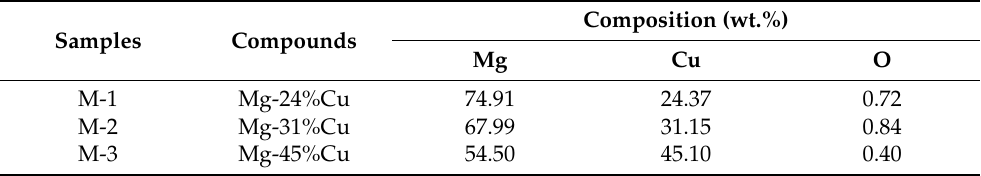
Table 1. The components of Mg–Cu